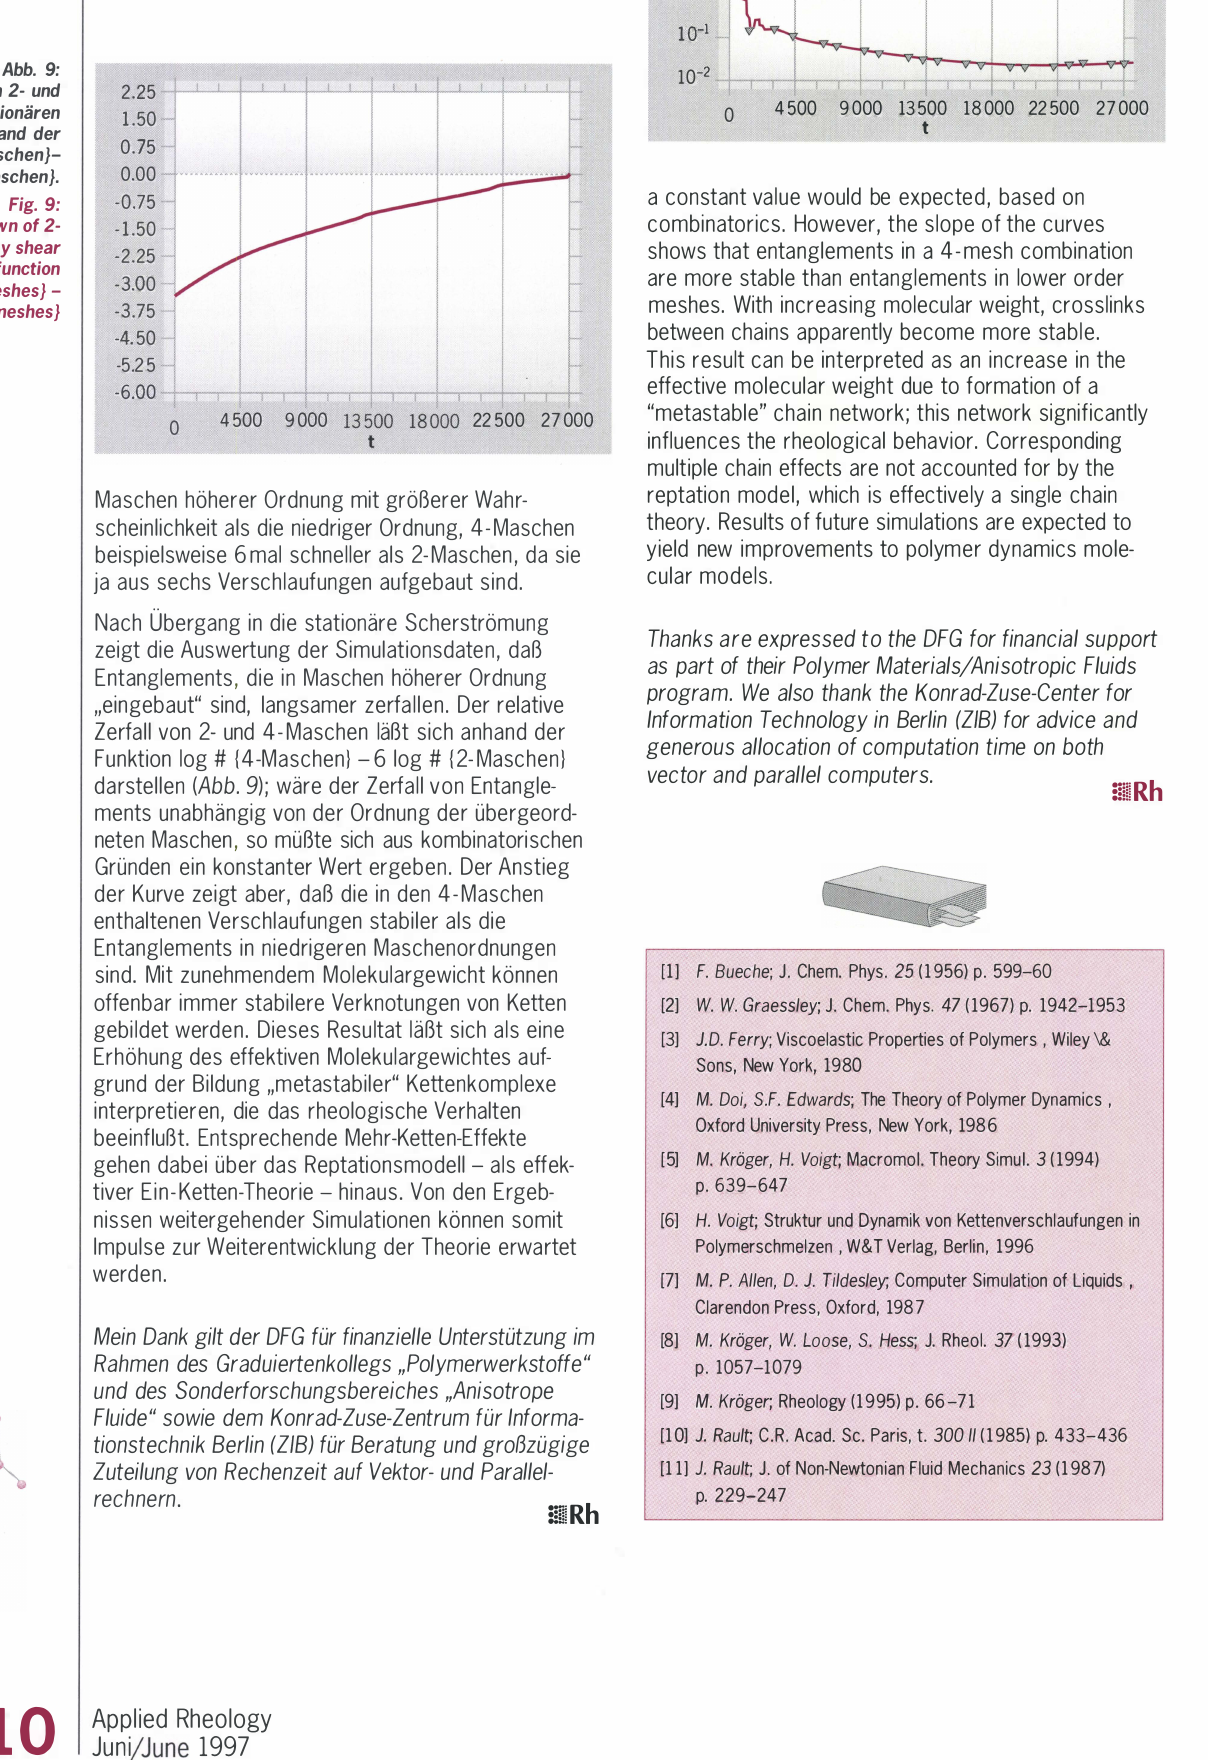
Break down of the entanglement network. Number